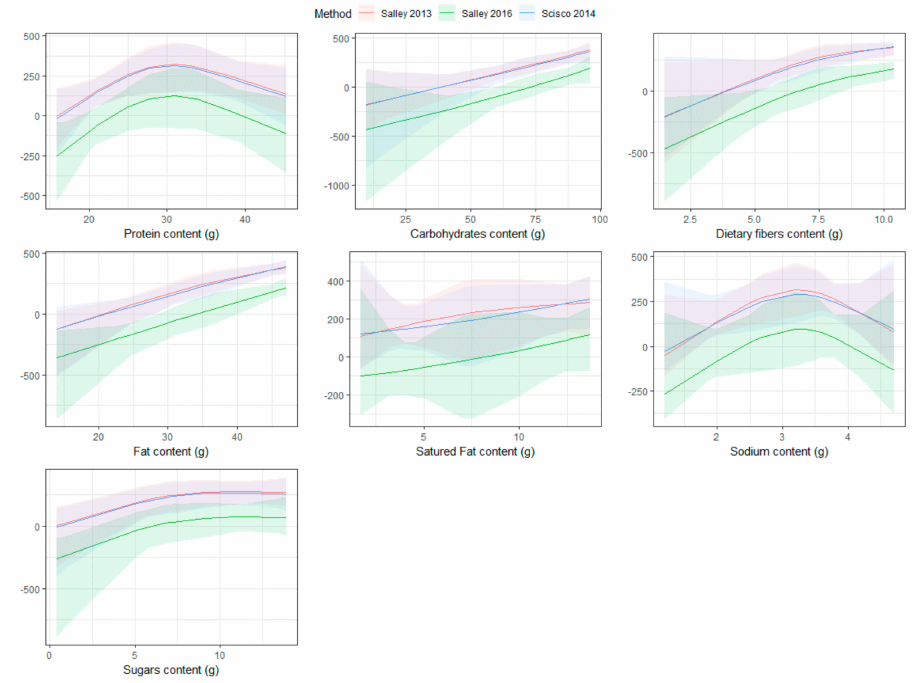
Figure 2. Association between nutritional values in (g), reported on the x -axis, and errors in estimated caloric intake in Kcal, reported on the y -axis. Lines and bands represent the estimated error and relative 95% CI, respectively. Colors represent the approach used to estimate caloric